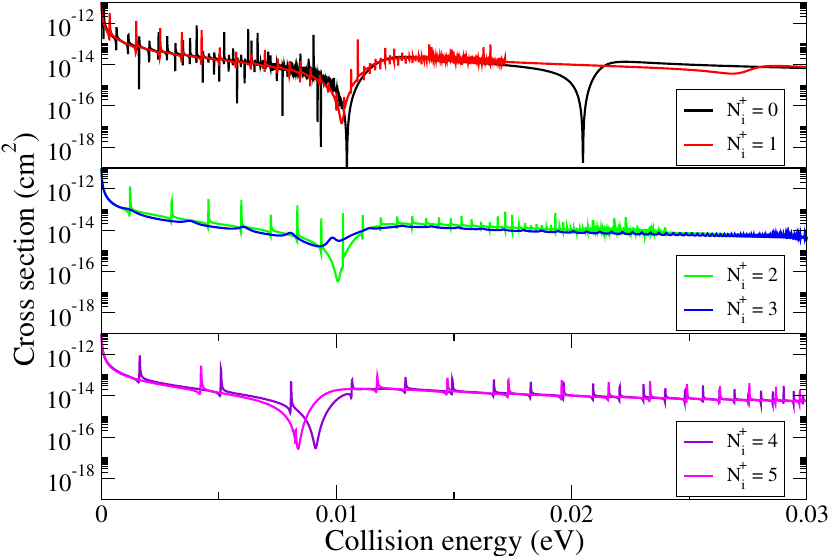
Figure 2. Cross sections for the dissociative recombination of vibrationally relaxed CH + ( X 1 Σ + ) on = 0 to 5 for electron collision energyin the range 0 − 30 initial rotational levels N + i